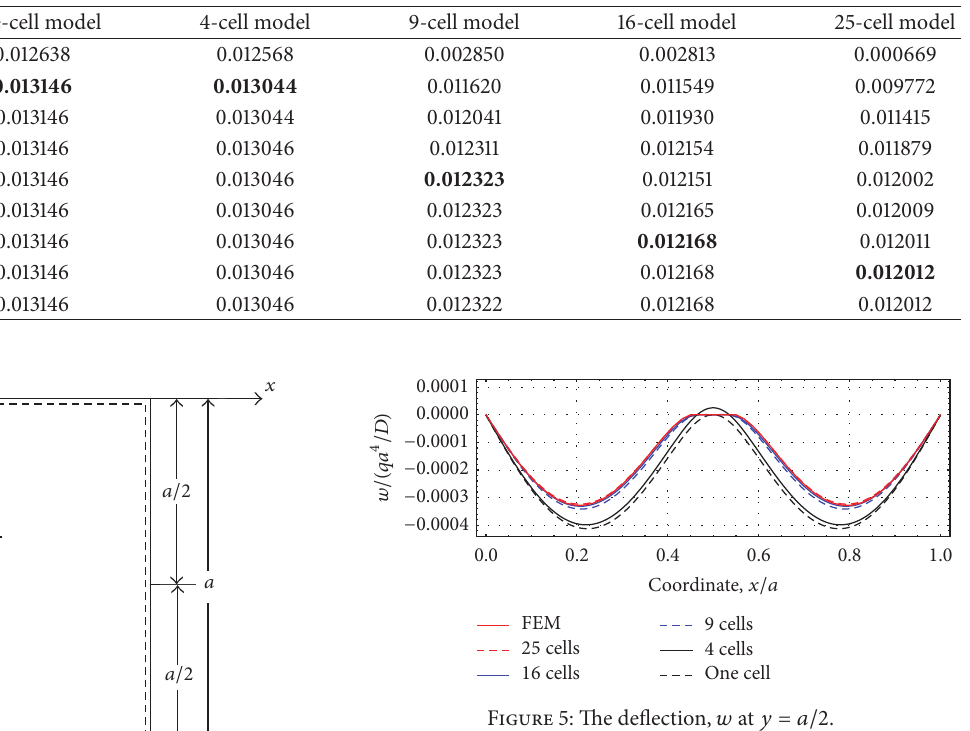
Table 2: Values of 𝑀 𝑥 /(𝑞𝑎 2 ) , at 𝑥 = 𝑎/4 , 𝑦 = 𝑏/4 .